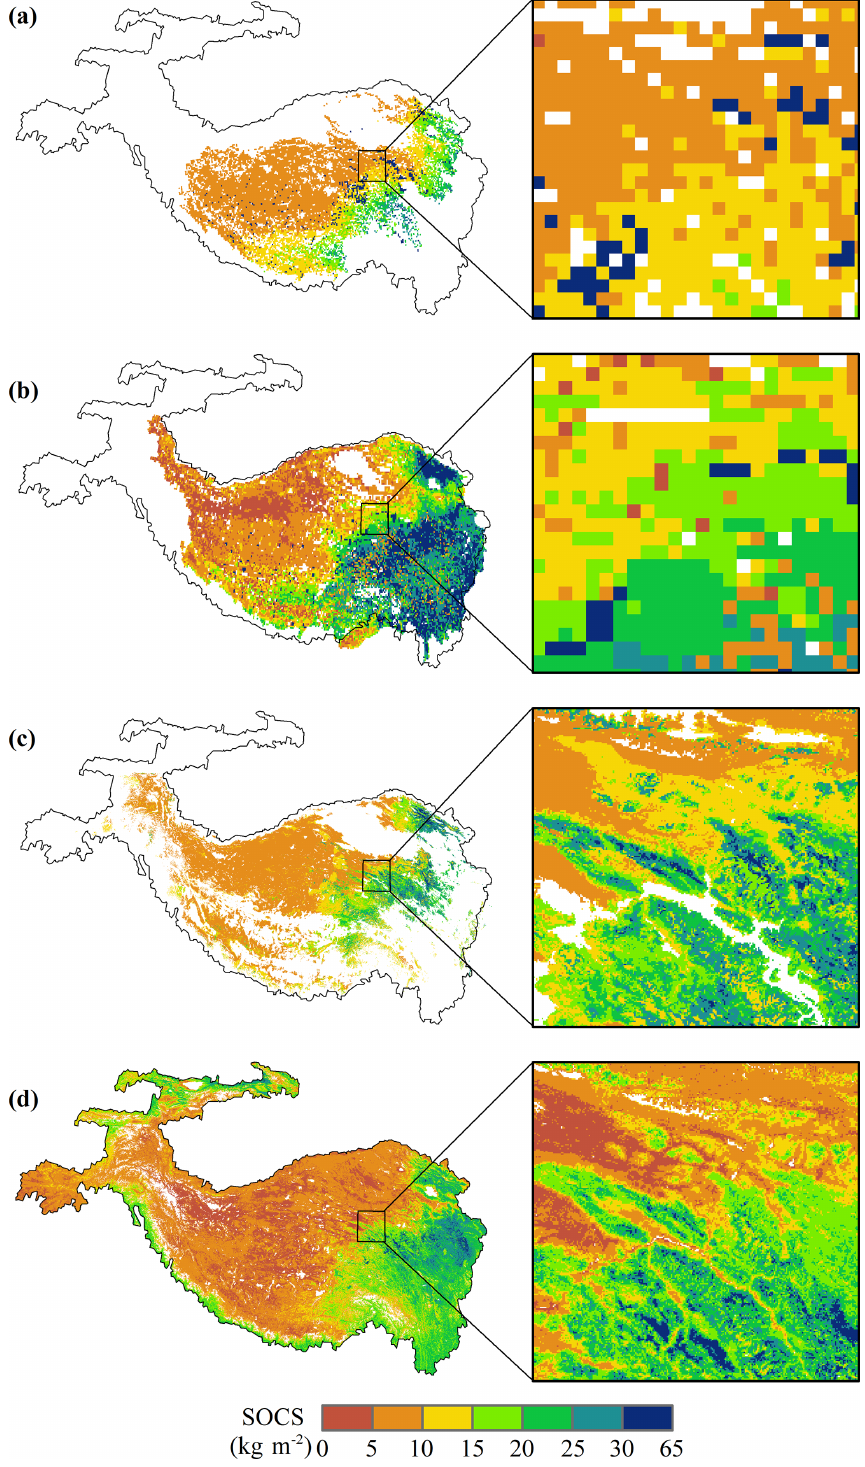
Figure 8. Comparison of spatial details of the predictions with the previous studies: SOCS at 0–300cm depth in the map excerpt of Budongquan area of Qinghai province, China. (a) Ding et al. (2016); (b) Ding et al. (2019); (c) Wang et al. (2020); (d) this study.